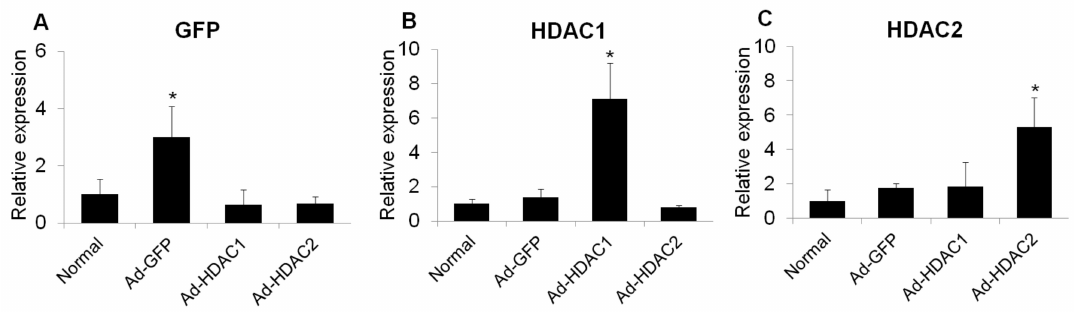
Figure 3. The mRNA expression of GFP ( A ), HDAC1 ( B ), and HDAC2 ( C ) in retinas at 3 days after intravitreal injection of adenovirus. Data were normalized to the expression of 18S-rRNA. Error bars, SD ( n = 10 retinas / group). * p < 0.001 compared to the normal retina. All comparisons were performed using one-way ANOVA with post hoc Bonferroni’s test.